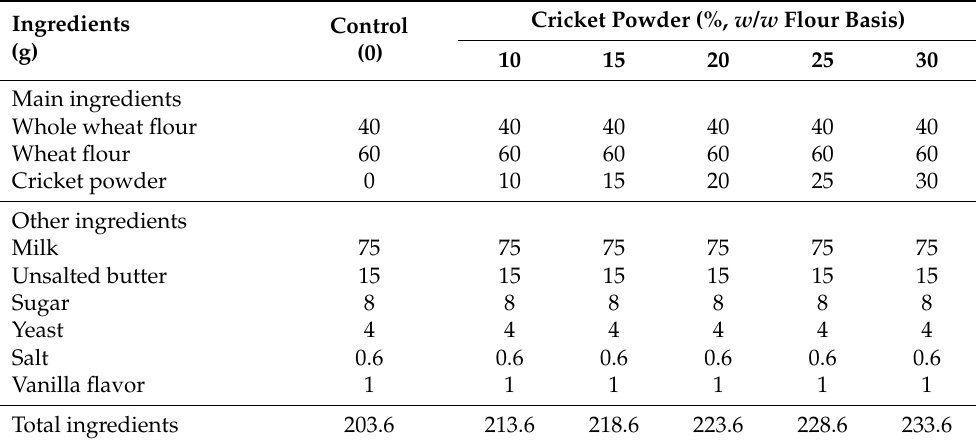
Table 1. Formulation of whole wheat bread enriched with cricket